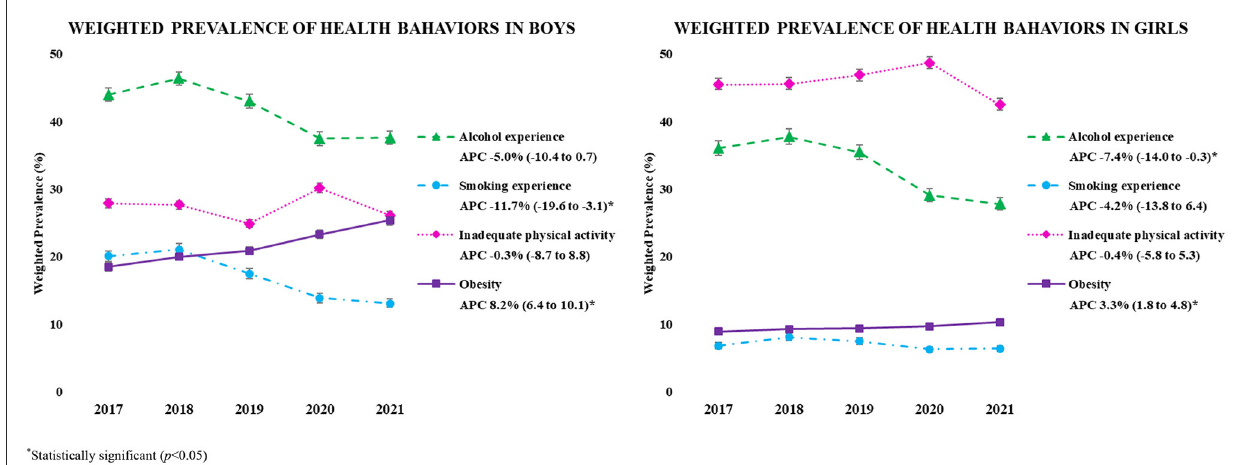
FIGURE1 The weighted prevalence of health behavior in the KYRBS 2017-2021 samples. * Statistically significant ( p < 0.05).